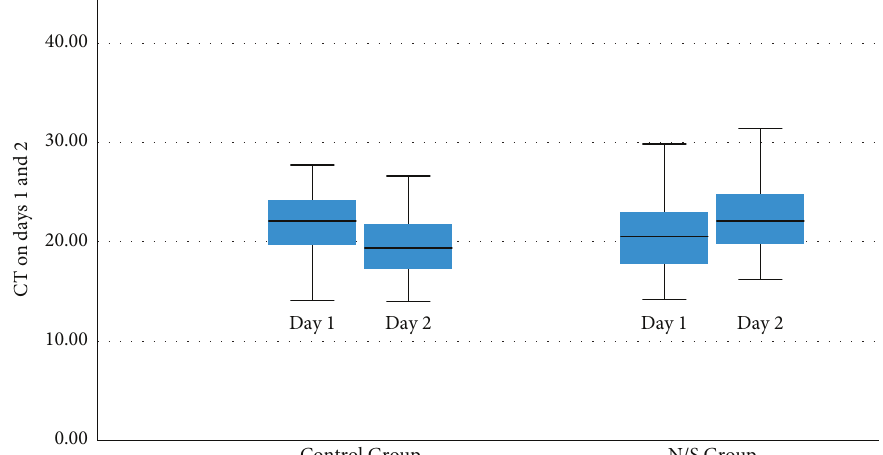
Figure 2: Mean N gene Ct values in day one and day two in both the groups. (CT: cycle threshold, N/S: normal